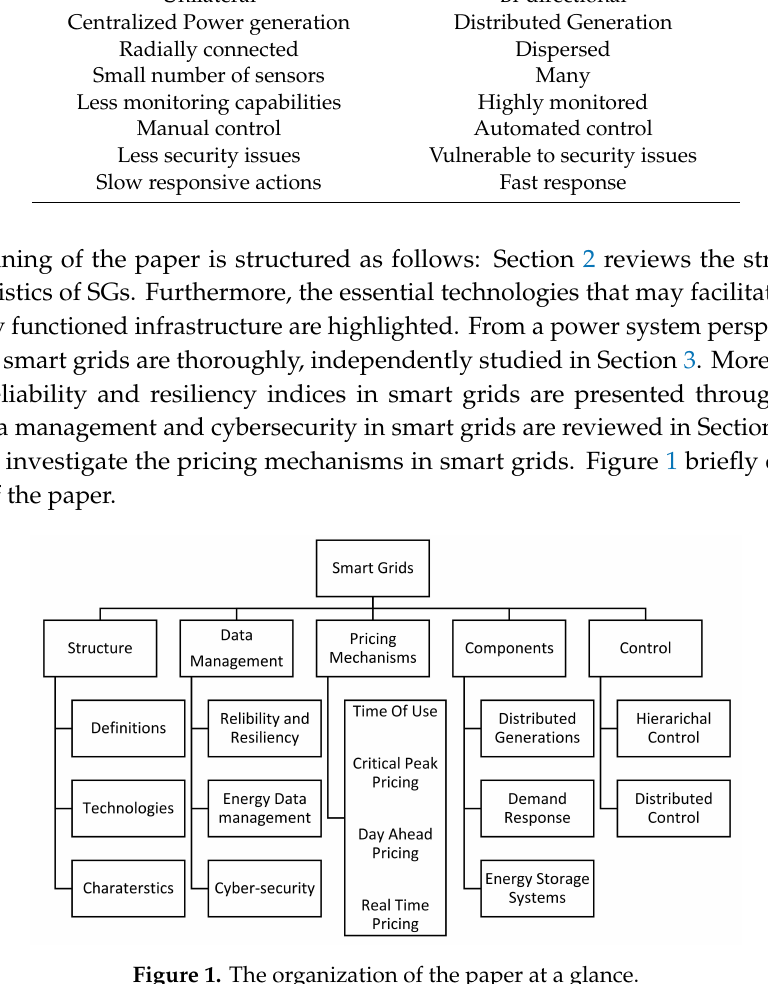
Figure 1. The organization of the paper at a